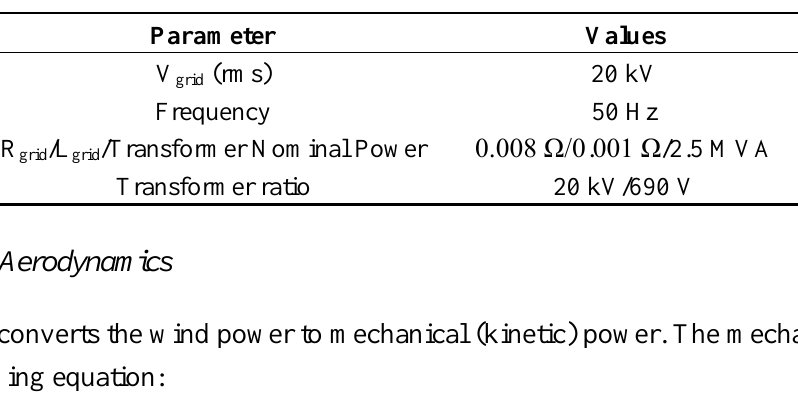
Table 1. Grid and transformer parameter values.